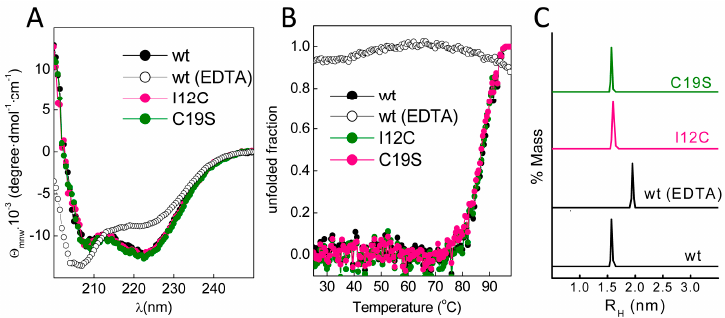
Figure 2. Conformational features of the Ca 2+ -bound Gad m 1 wt and mutant chains. ( A ) Far-ultraviolet (UV) CD spectra of Ca 2+ -bound Gad m 1 chains depicting their helical fold. ( B ) Thermal denaturation of Ca 2+ -bound Gad m 1 chains displaying the cooperativity and stability of their folds. Denaturation curves were obtained from the changes in molar ellipticity at 222 nm that occurred upon heating. ( C ) Hydrodynamic radius of Gad m 1 chains derived from DLS measurements with an average polydispersity of 5–10%. The label wt ethylenediaminetetraacetic acid (EDTA) corresponds to Gad m 1 wt treated with 5 mM EDTA, which was included as a folding control. R H : hydrodynamic radii, θ mrw: mean residue weight ellipticity.